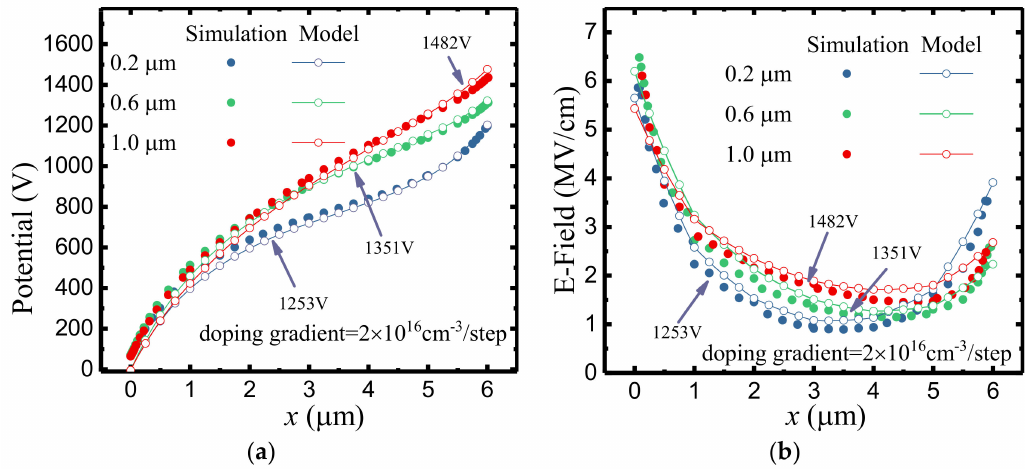
Figure 9. ( a ) The potential distributions and ( b ) the E–field distributions of SDC–HEMTs with different channel